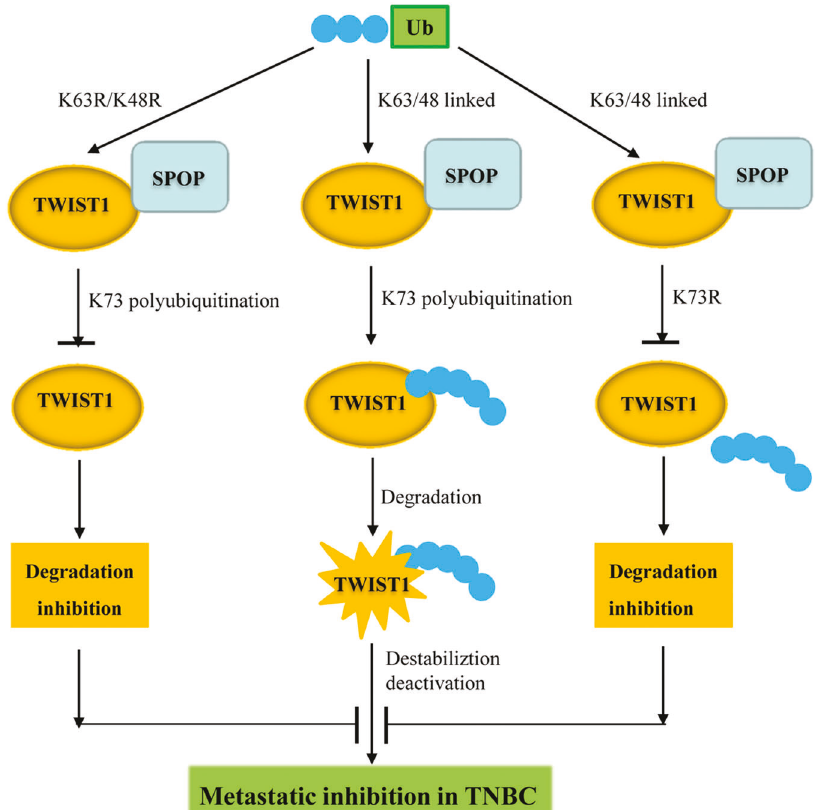
Fig. 8 A working mechanistic model underlying SPOP mediated TWIST1 degradation and metastasis inhibition. SPOP mediated TWIST1 degradation and metastasis inhibition can be modulated by K63-linked and K48-linked TWIST1 ubiquitination at site K73; either mutated K63R/K48R of Ub or mutated K73R of TWIST1 disrupted SPOP-mediated TWIST1 ubiquitination and its further depredation, thereby blocking metastasis inhibition in K63-linked and K48-linked polyubiquitination at K73 in TWIST1 trigger its degradation by SPOP, thereby preventing EMT and